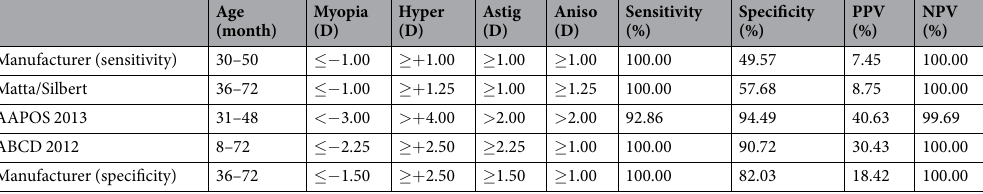
Table 3. Accuracy for detecting refractive amblyopia risk factors. PPV, positive predictive value; NPV, negative predictive value.